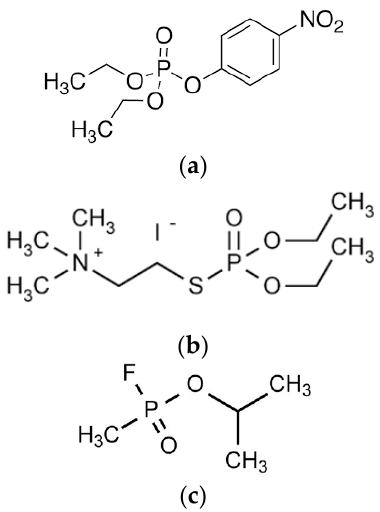
Figure 1. The structure of three organophosphorus compounds: ( a ) the organophosphate, paraoxon (the active metabolite of the pesticide parathion); ( b ) the organophosphorothioate, echothiophate iodide (an anti-glaucoma drug used in eye drops); ( c ) the organophosphonate, sarin ( a banned chemical weapon agent).